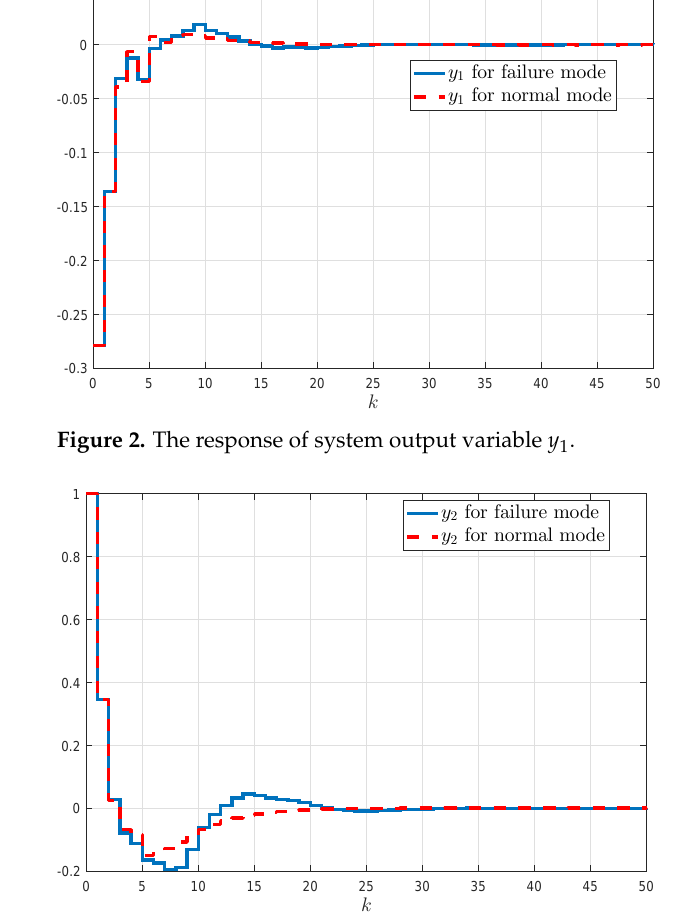
Figure 3. The response of system output variable y 2 .